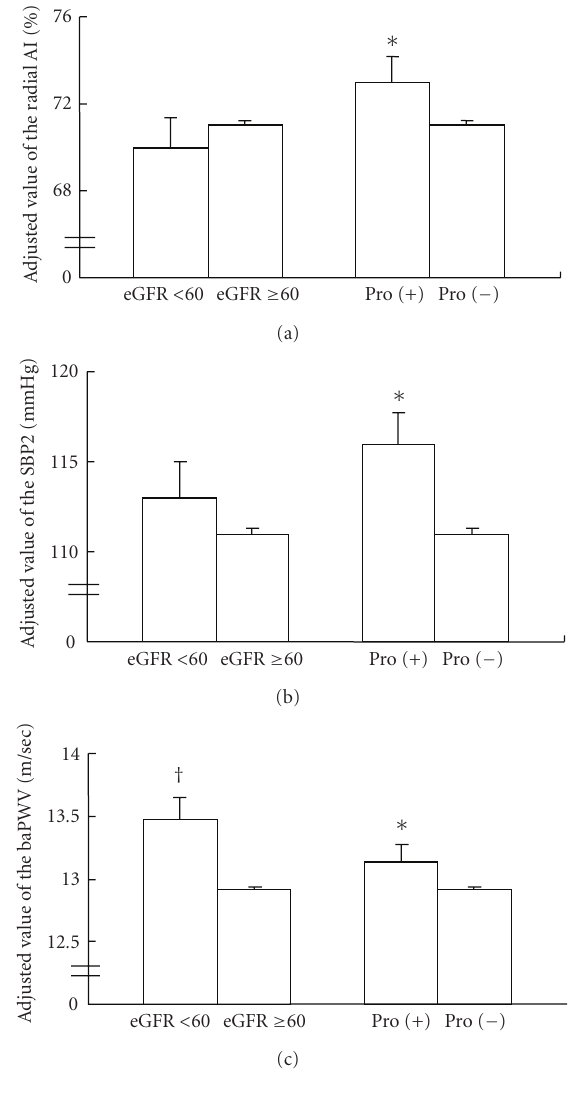
Figure 1: Adjusted values of the radial augmentation index, second peak of the radial pressure waveform, and brachial-ankle pulse wave velocity in subjects classified by the presence/absence of proteinuria or eGFR ≥ 60mL/min per 1.73m 2 / < 60mL/min per 1.73m 2 . Abbreviations . radial AI: radial augmentation index; SBP2: second peak of the radial pressure waveform; baPWV: brachial- ankle pulse wave velocity; ∗ P < . 05 versus subjects without proteinuria; † P < . 05 versus subjects with eGFR ≥ 60mL/min per 1.73m 2 .